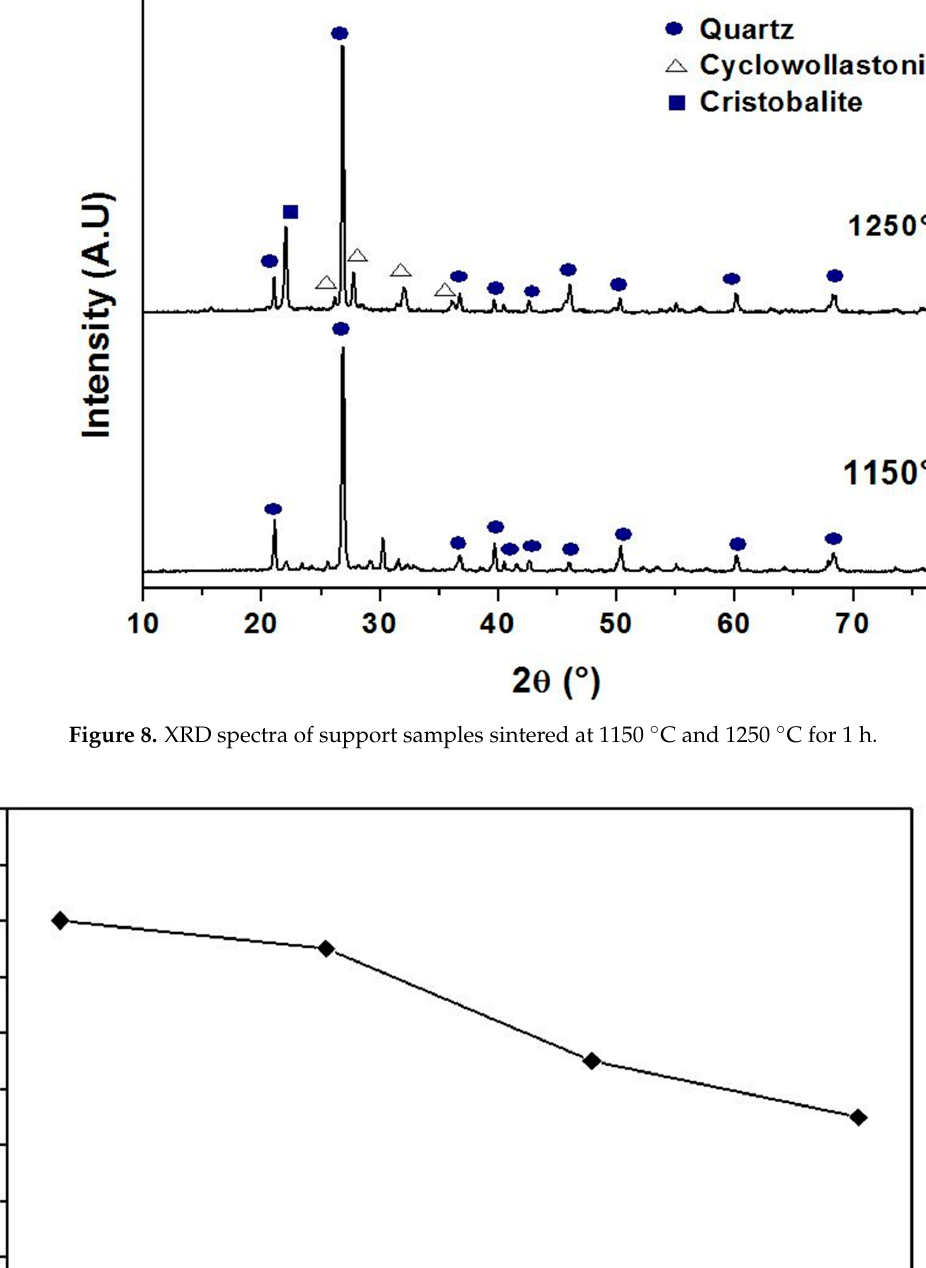
strength for supports at 1200 °C, but almost similar values of porosity ratio.